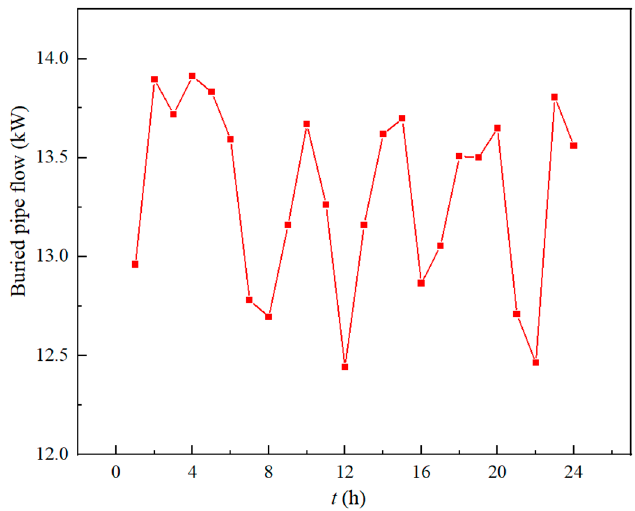
Figure 12. Buried pipe flow in each period when the objective function is geothermal energy utili- zation coefficient.